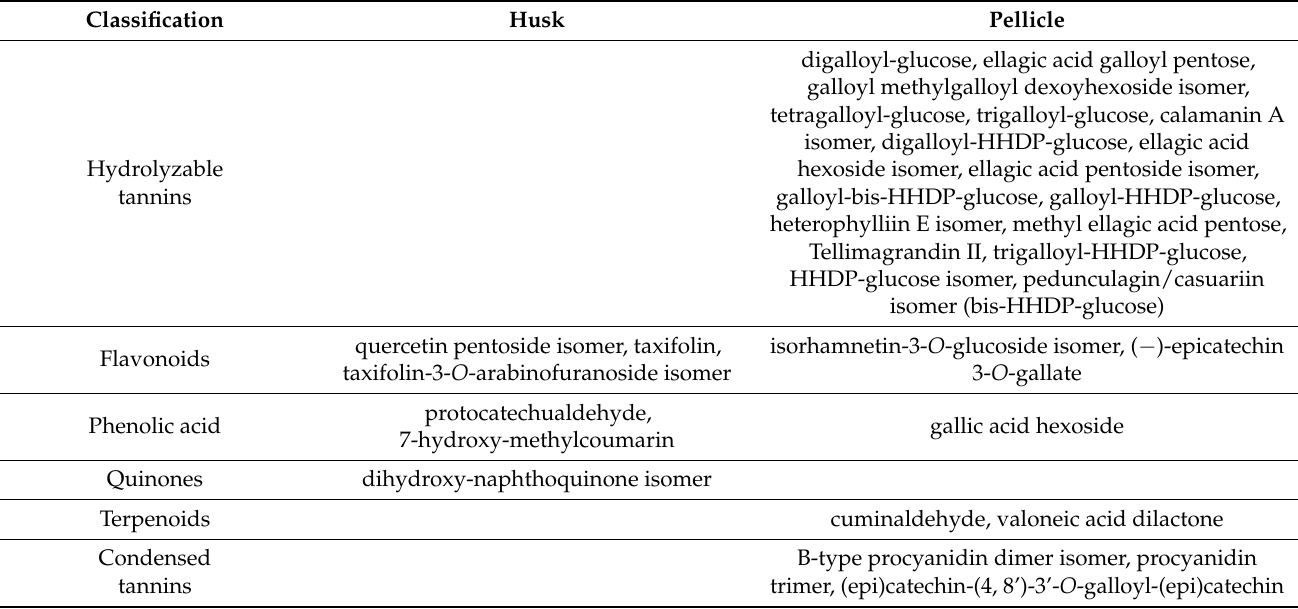
Table 2. Classification of different components in husk and pellicle of